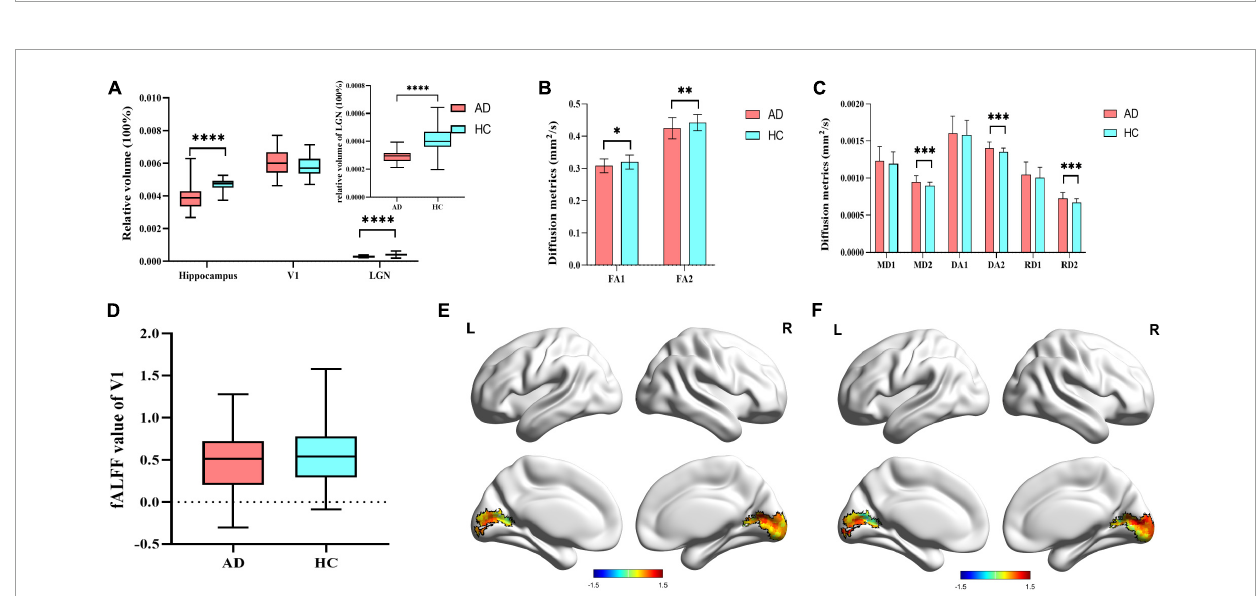
FIGURE2 Differences in multimodal MRI. (A) Difference of 3D-T1WI results. (B) Difference of FA value in the visual pathway. FA1 represent FA value of optic tract, and FA2 represent FA value of optic radiation. (C) Difference of other diffusion metrics in the visual pathway. MD1, DA1, and RD1 represent MD, DA, and RD values of optic tract, respectively. MD2, DA2, and RD2 represent MD, DA, and RD values of optic radiation, respectively. (D) Difference of fALFF value of V1 in AD group and HCs group; (E) fALFF value of V1 in AD patients; (F) fALFF value of V1 in HCs. V1, primary visual cortex; LGN, lateral geniculate nucleus; FA, fractional anisotropy; MD, mean diffusivity; DA, axial diffusivity; RD, radial diffusivity; fALFF, fractional amplitude of low frequency fluctuations. Significant differences are indicated by square brackets. ∗ Denotes p < 0.05, ∗∗ denotes p < 0.01, ∗∗∗∗ means p <